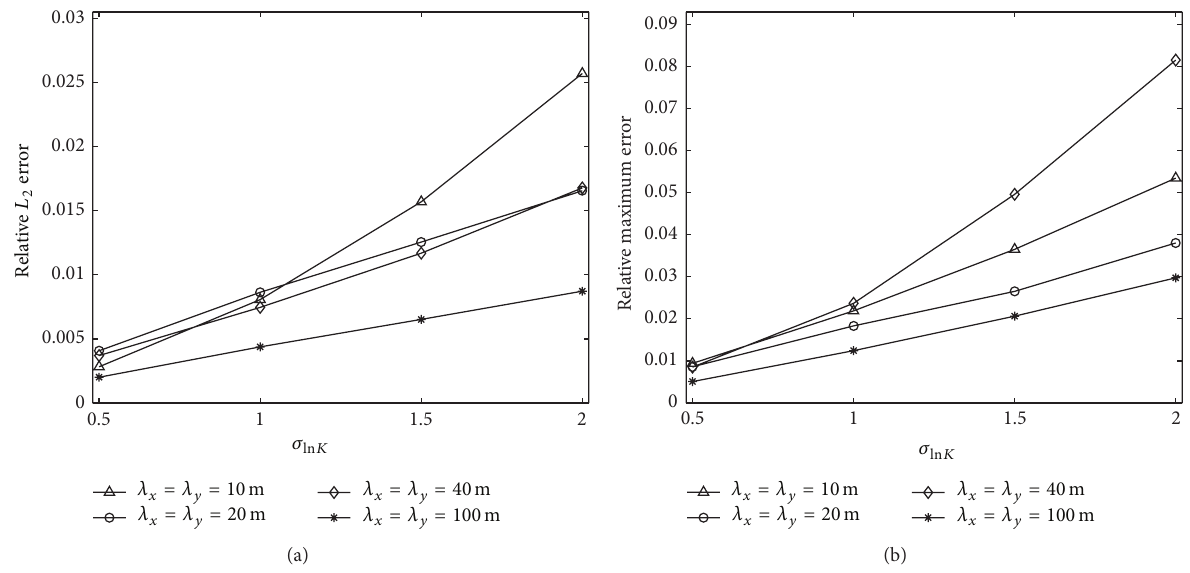
Figure5:Relative(a) 𝐿 2 and(b)maximumerrorsbetweenthefine-scalemodelandthenewschemeforthesteadyflowproblemwithisotropic correlation